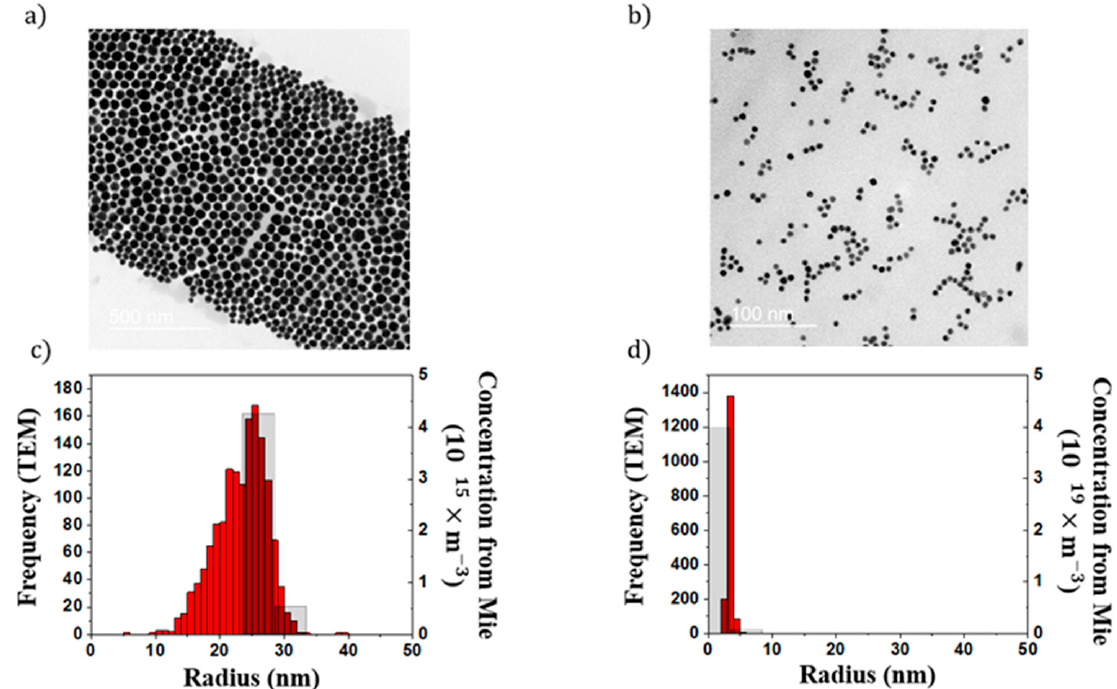
Figure 8. ( a , b ) TEM images of ( a ) P1 and ( b ) P2 NPs. ( c , d ) NPs size distribution of ( c ) P1 and ( d ) P2 determined by TEM (in red) extinction spectroscopy (in grey).